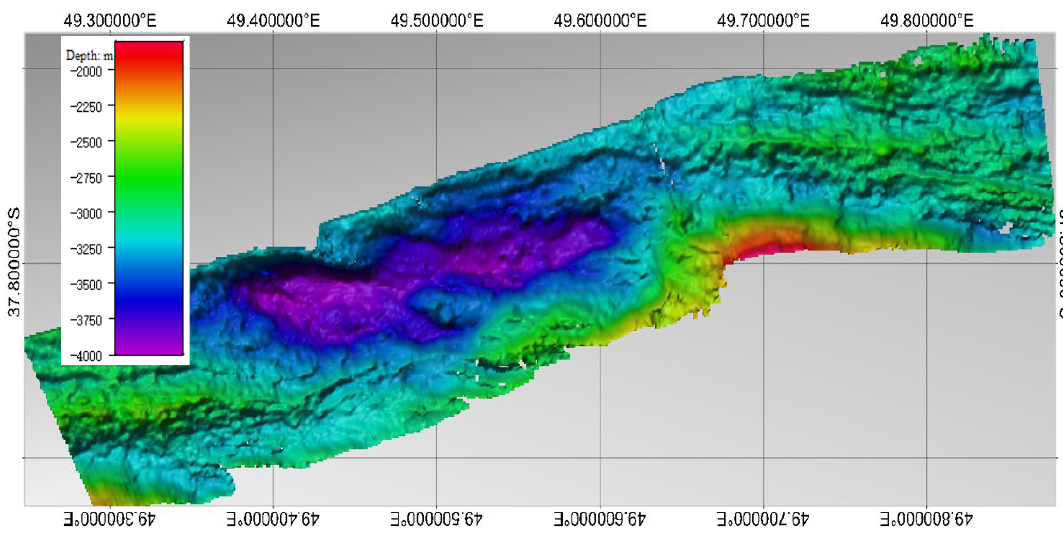
Figure 3. High-precision seabed DTM (100 m × 100 m grid) in the Longqi hydrothermal area.